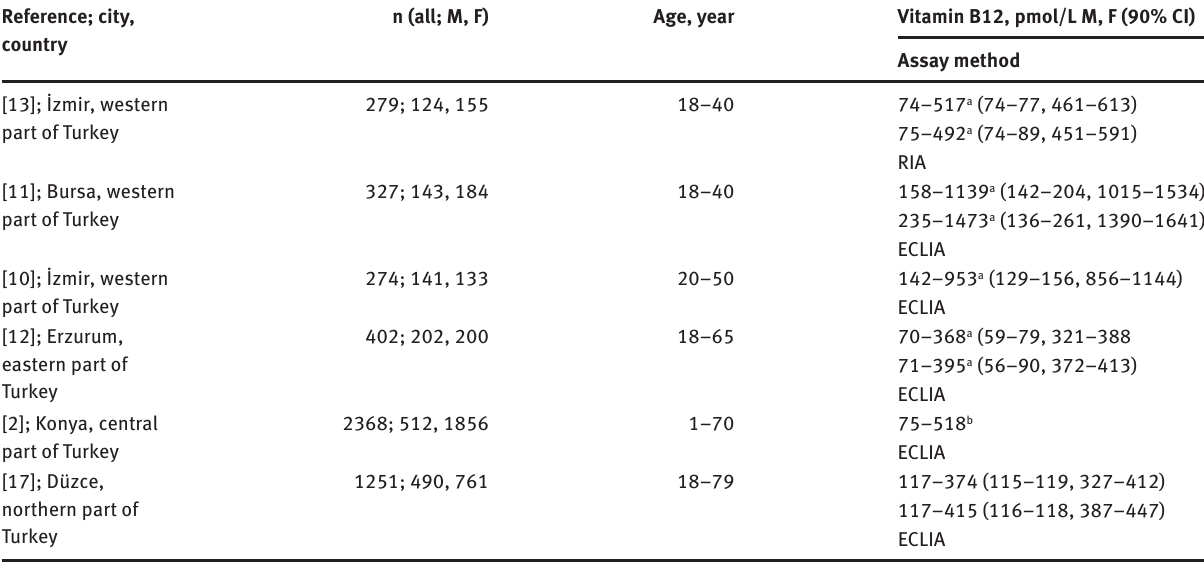
Table 3: Vitamin B12 RI studies in our country. Reference; city,